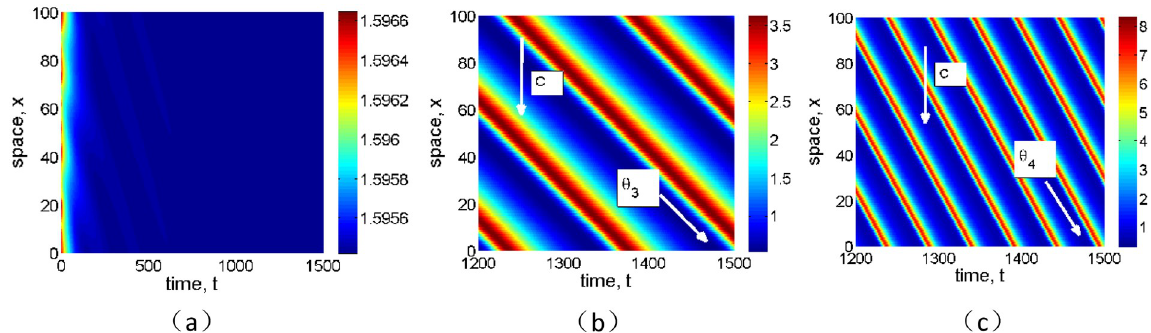
Fig 9. Effects of infiltration positive feedback coefficient α on the formation of spatial pattern for tree. The fixed parameter values p = 0.1, δ = 0.045, v = 30, and (a) α = 0, (b) α = 0.01 and (c) α = 0.03.